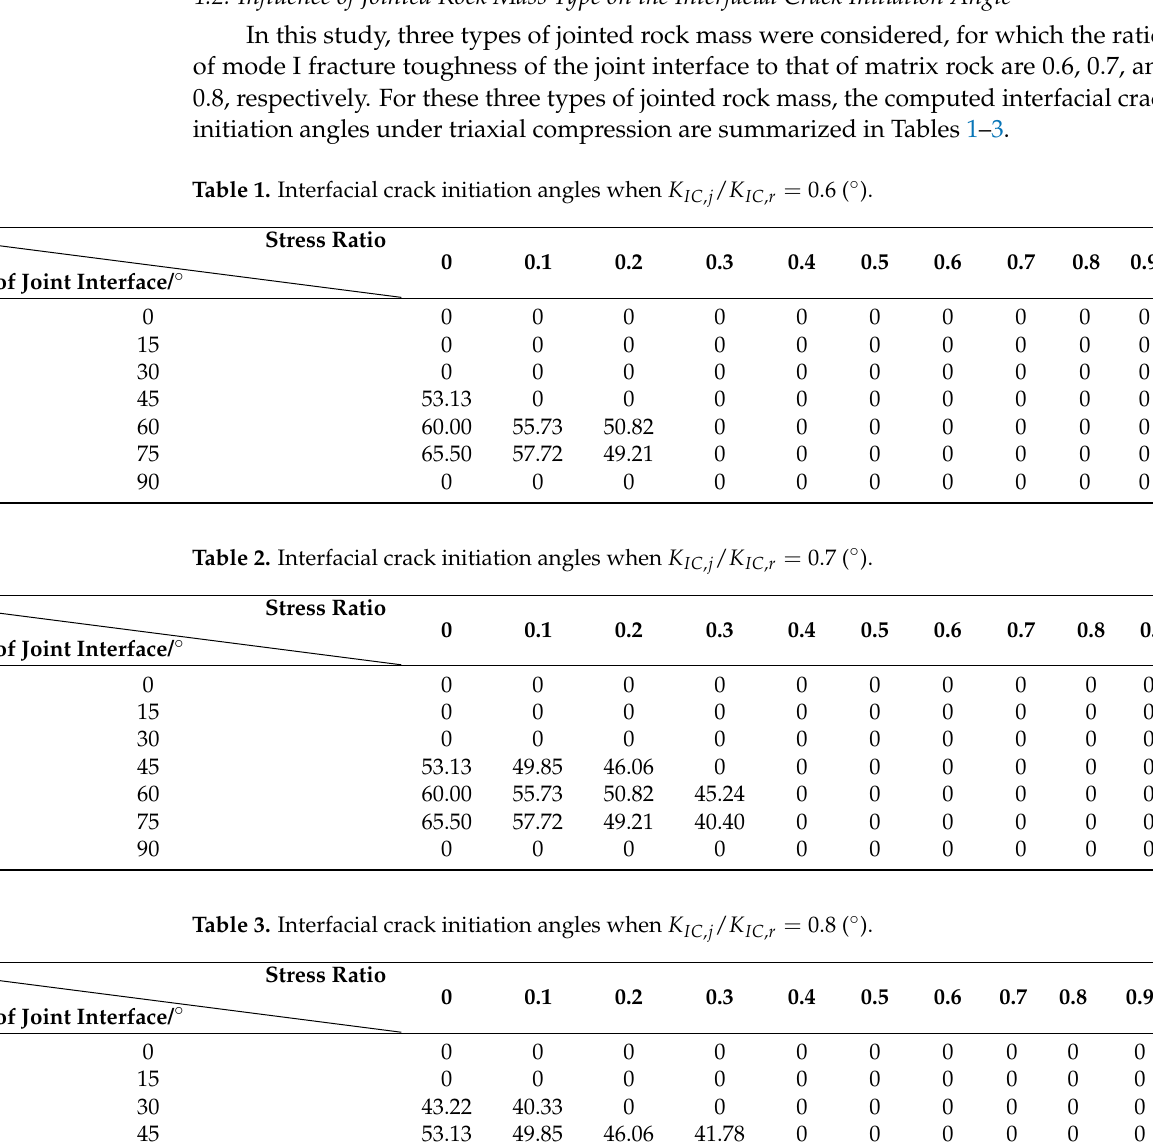
Table 1. Interfacial crack initiation angles when K IC , j / K IC , r = 0.6 ( ◦ ).